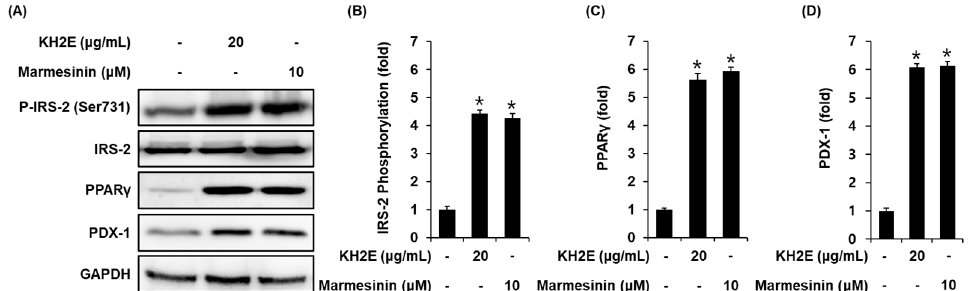
Figure 7. E ff ect of KH2E and marmesinin ( 19 ) on the protein expression levels of phospho-insulin receptor substrate-2 [P-IRS-2 (Ser731)], IRS-2, peroxisome proliferator-activated receptor γ (PPAR γ ), and pancreatic and duodenal homeobox 1 (PDX-1). ( A ) Protein expression levels of P-IRS-2 (Ser731), IRS-2, PPAR γ , PDX-1, and GAPDH (glyceraldehyde 3-phosphate dehydrogenase) in INS-1 cells treated or untreated with 20 µg/mL KH2E and 10 µM marmesinin ( 19 ) for 24 h. ( B – D ) Each bar graph presents densitometric quanti fi cation of western blot bands. Data represent the mean ± S.E.M., n = 3, * p < 0.05 compared with the control.